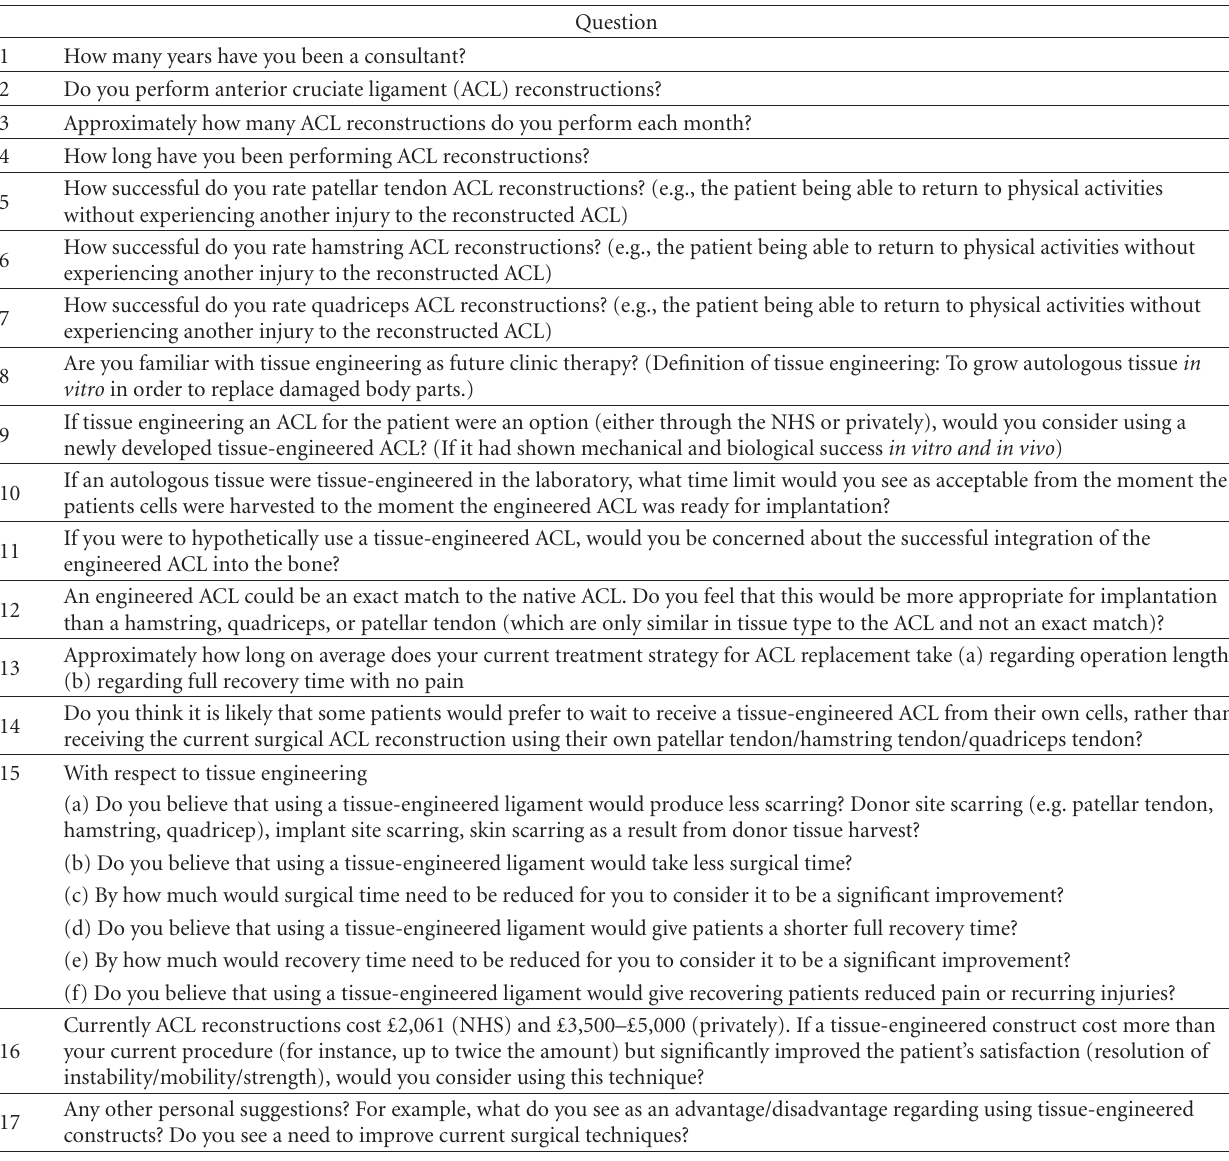
Table 1: Questionnaire used online for orthopaedic consultant